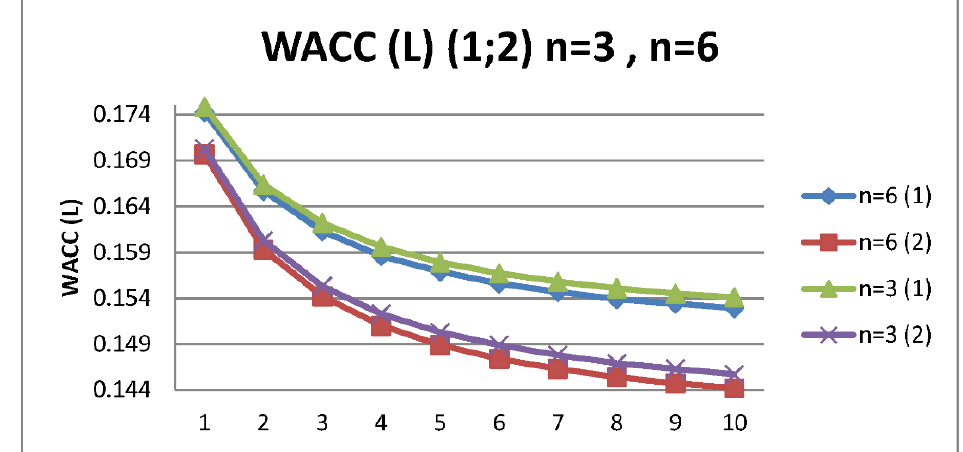
Figure 7. Dependence of the weighted average cost of capital, WACC , on leverage level L in the cases of payments of tax on profit at the end of the year (1) and in the beginning of the year (2) for three-year and six-year companies.